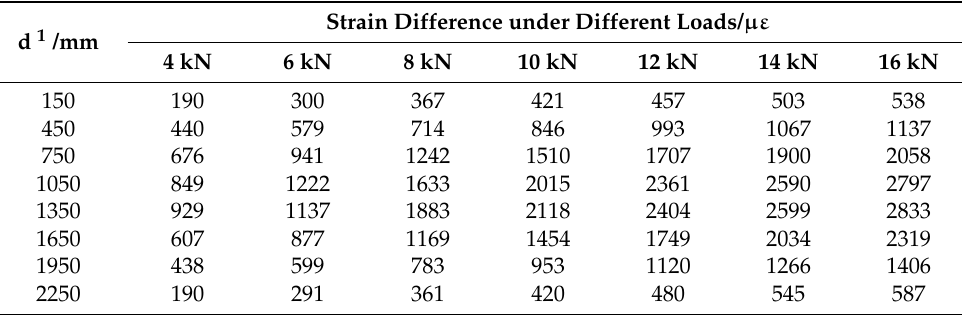
Table 4. Strain difference between the upper and lower surfaces for each